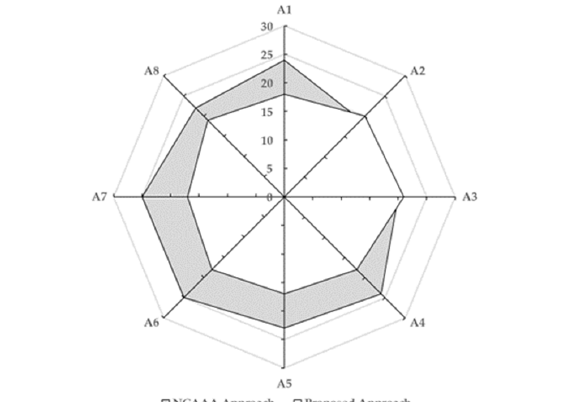
Fig. 2. Comparison of the total quality ratings for the eight educational programs (The NCAAA approach vs. the Proposed